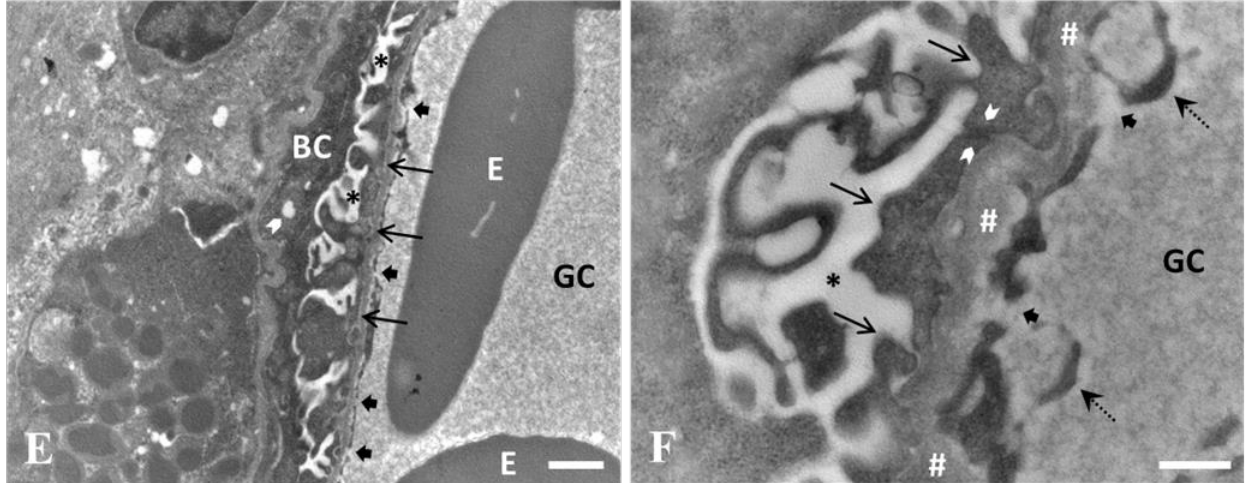
Figure 1. Transmission electron micrographs of the glomerular filtration barrier in unexposed carp ( A , B ), carp exposed to PFOA 200 ng L − 1 ( C ), and carp exposed to 2 mg L − 1 ( D – F ). ( A ) The normal architecture of the glomerular filtration barrier is shown. The large bodies of podocytes (P) are appreciable, along with the typical interdigitated finger-like tertiary foot processes (pedicels) (thin arrows), contacting the underlying basement membrane, interposed between the foot processes and the fenestrated endothelium (large arrows) of glomerular capillaries (GC). (BC) Bowman’s capsular epithelium. (E) Erythrocyte. (*) Urinary space. Scale bar = 1 µ m. ( B ) The slit diaphragm is appreciable as a fine electron-dense line bridging contiguous pedicels (thin arrows) in correspondence of each filtration slit. The typical fenestrae (large arrows) of the fenestrated endothelium of glomerular capillaries (GC) are visible. (*) Urinary space. Scale bar = 0.5 µ m. ( C ) The glomerular filtration barrier of a carp exposed to the lowest tested concentration (200 ng L − 1 ) shows a substantially maintained architecture (cf. ( A )), with particular regard to the relative number of filtration slits and the integrity of slit diaphragms (thin arrows) and fenestrae (large arrows) of the fenestrated endothelium of glomeru- lar capillaries (GC). (BC) Bowman’s capsular epithelium. (*) Urinary space. Scale bar = 0.25 µ m. ( D ) The glomerular filtration barrier shows podocyte effacement, with a drastic reduction in the number of filtration slits, the fusion of pedicels, and the occurrence of a large, continuous cytoplas- mic sheet (thin arrows). Focal vacuolations are visible in the podocyte (P) cell body and processes (arrowheads). Furthermore, foamy proteinaceous material (ˆ) is observable in the urinary space (*). (E) Erythrocyte. (GC) glomerular capillary. (Large arrows) fenestrated endothelium. Scale bar = 1 µ m. ( E ) Evidence of foot process fusion (thin arrows) is appreciable with the disappearance of filtration slits in the glomerular filtration barrier. A single focal vacuolation (arrowhead) is observable in an epithelial cell of Bowman’s capsule (BC). (*) Urinary space. (E) Erythrocyte. (GC) glomerular capillary. (Large arrows) fenestrated endothelium. Scale bar = 1 µ m. ( F ) At higher magnification, pedicles (thin arrows) appear distorted, enlarged, and filtration slits drastically reduced, compared to unexposed carp (cf. ( B )) and carp exposed to the lowest tested concentration (cf. ( C )). There is no evidence of slit diaphragms in the occasionally present filtration slits. Evidence of close contact is appreciable between the cell membranes of two contiguous pedicels (arrowheads). Disarrangement and enlargement of the basement membrane (#) are also present compared to the carp of the other two experimental groups (cf. ( B , C )). Furthermore, irregular villous-like cytoplasmic projections are visible (dotted arrows). (Large arrows) fenestrae of fenestrated endothelium. (*) Urinary space. (GC) glomerular capillary. Scale bar = 0.4 µ